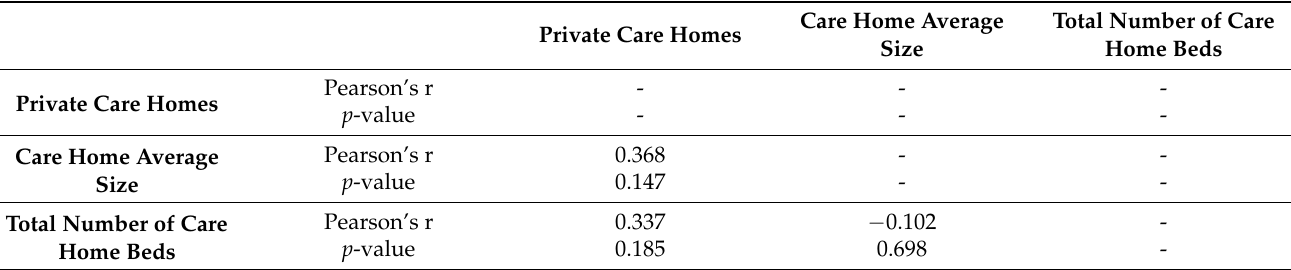
Table 5. Correlation matrix between home-related independent